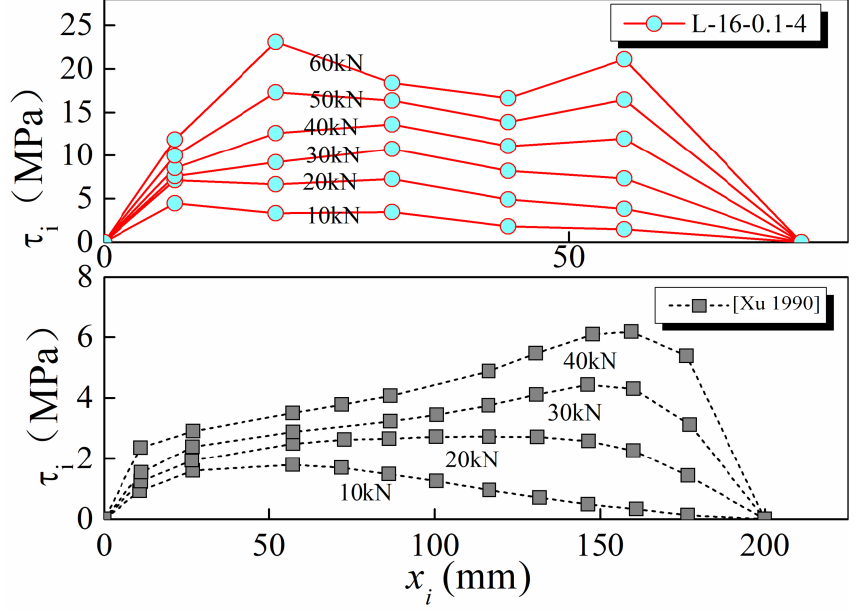
Figure 9. Strain distributions of x i τ i under different loading levels [23].